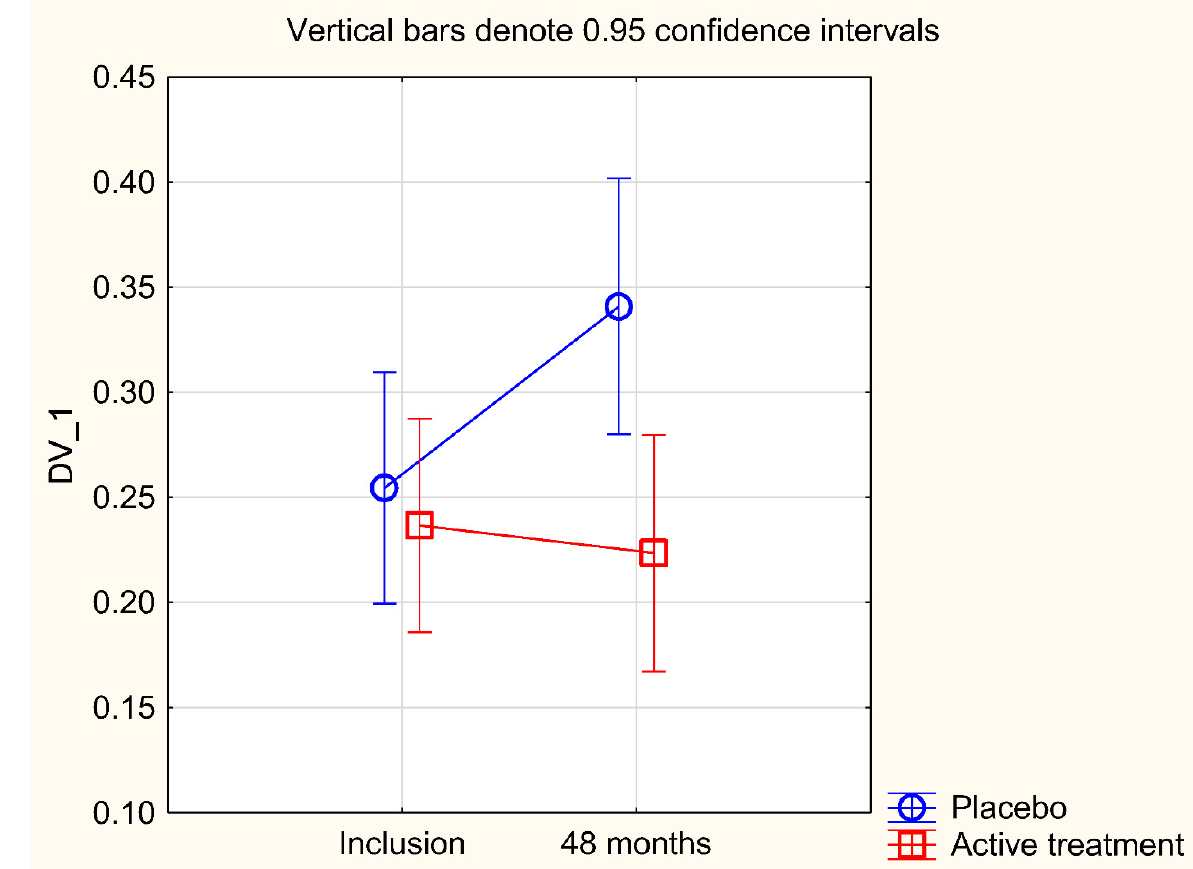
Figure 1. Concentration of D-dimer at the start of the project and after 48 months in the selenium and coenzyme Q 10 treatment group compared to the placebo group in the study population. Evaluation performed by use of repeated measures of variance methodology. Current effect: (F(1,111) = 5.11; p = 0.026). Vertical bars denote 0.95 confidence intervals. Blue curve: Placebo; Red curve: Active treatment group. Bars indicate ±95% CI.